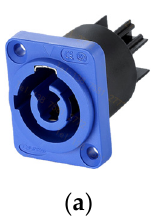
Figure 16. Hand–eye calibration error: ( a ) X coordinate hand–eye calibration error; ( b ) Y coordinate hand–eye calibration error; ( c ) Z coordinate hand–eye calibration error.